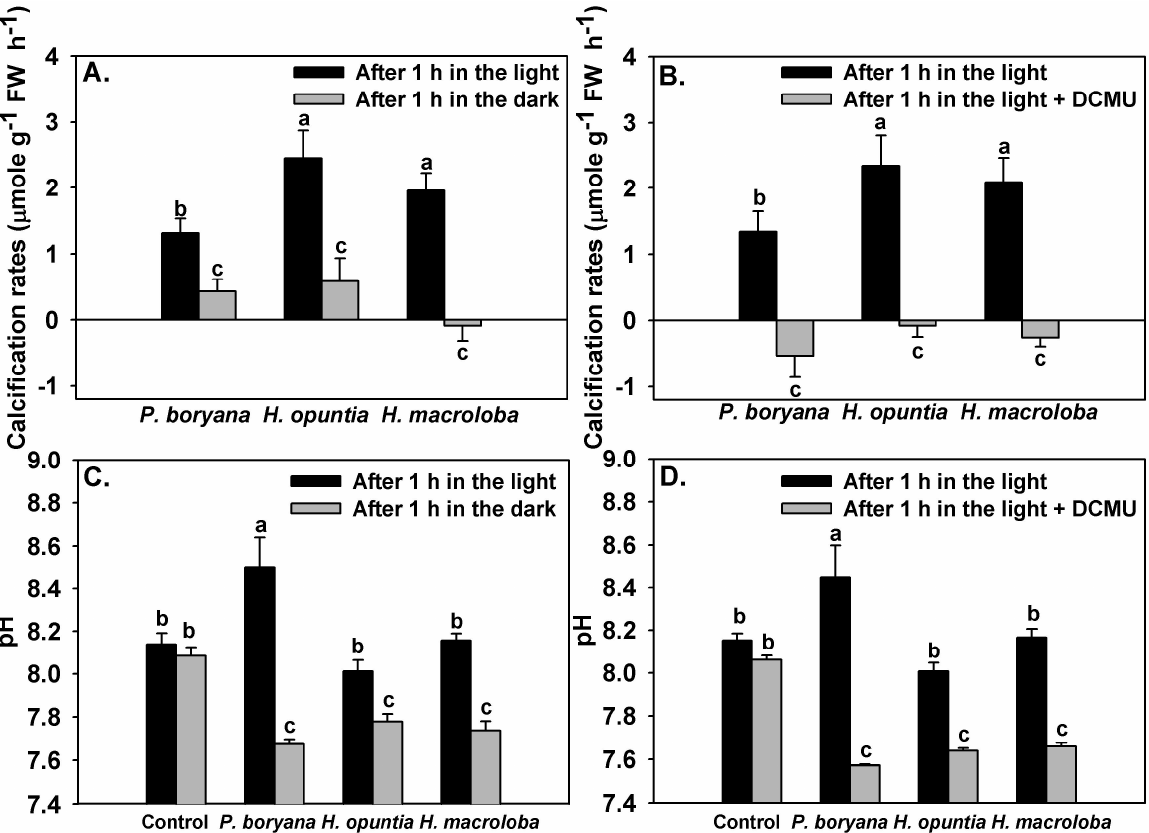
Figure 5. Effects of inhibition of photosynthesis on calcification rates of Padina boryana , Halimeda opuntia and Halimeda macroloba ( A, B ) and seawater pH ( C, D ) after 1 h incubation under an irradiance of 150 µmol photons m − 2 s − 1 . Bars without shared letters are considered statistically different (Fisher’s LSD test, p < 0.05). Data are means ± SE (n = 9).